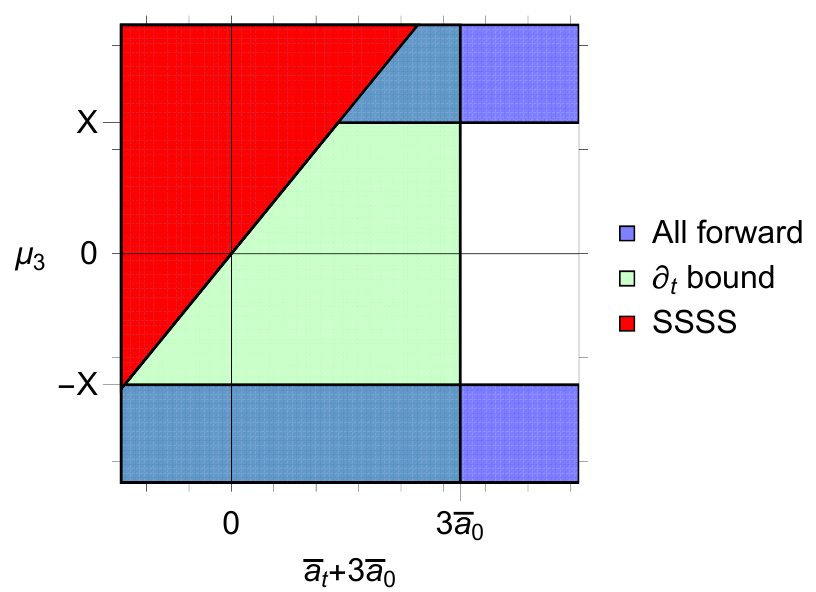
Figure 1 . Parameter space for charged Galileon theory constrained by analyticity. A suppressed a 0 (cid:24) m 2 = (cid:3) 2 is required to recover a Galileon symmetry in the decoupling limit. The forward limit (cid:30) bound from scattering four scalar modes was previously found in [7], which excluded the red region. By looking at scattering superpositions of modes, one use forward limit bounds to further restrict the parameter space to a semi-in(cid:12)nite strip (the white region plus the light green region) in the parameter space spanned by ( (cid:22) 3 ; (cid:22) a t + 3(cid:22) a 0 ). Utilizing the (cid:12)rst @ t bound (i.e., going away from the limited forward limit formalism), we reduce this semi-in(cid:12)nite strip even further, potentially greatly, depending on the sign of 3(cid:22) a 0 = 3 a 0 (cid:0) a 5 (cid:0) C 1 (cid:0) 4 C 2 . In terms of the EFT coe(cid:14)cients in (3.5), we have 2(cid:22) a t = a 3 + a 4 (cid:0) 2 a 5 ; (cid:22) 3 = a 4 (cid:0) a 5 (cid:0) a 3 = 2 (cid:0) C 1 = 2 (cid:0) 2 C 2 . The SSSS bound corresponds to (cid:22) a t + 3(cid:22) a 0 (cid:0) 2 (cid:22) 3 >